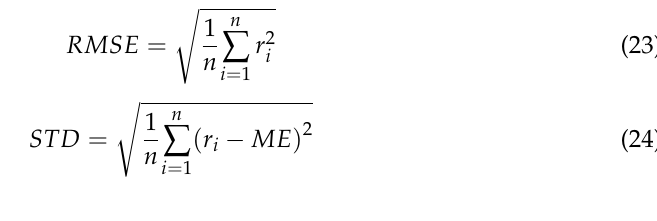
Table 4. Statistic indicators comparisons.